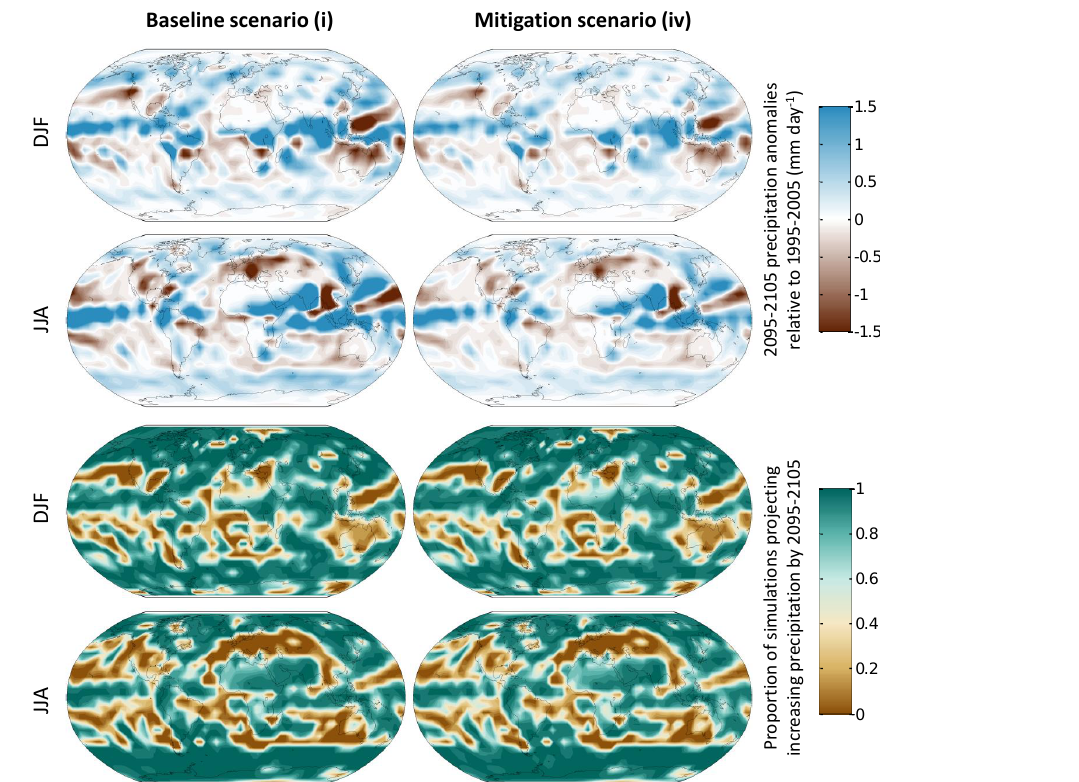
Figure 6. 2095–2105 precipitation anomalies (ensemble means) relative to 1995–2005 under the baseline scenario i, and the mitigation scenario iv (top panels) and proportion of ensemble members simulating increased precipitation (bottom